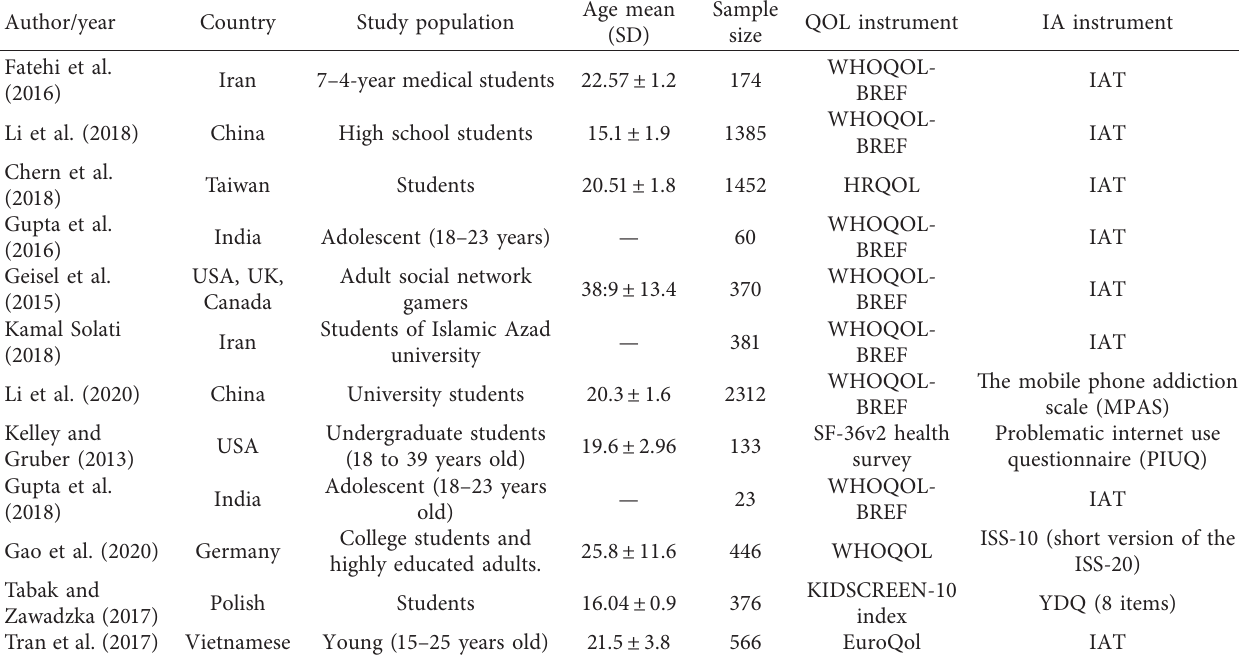
Table 1: Data extraction results from